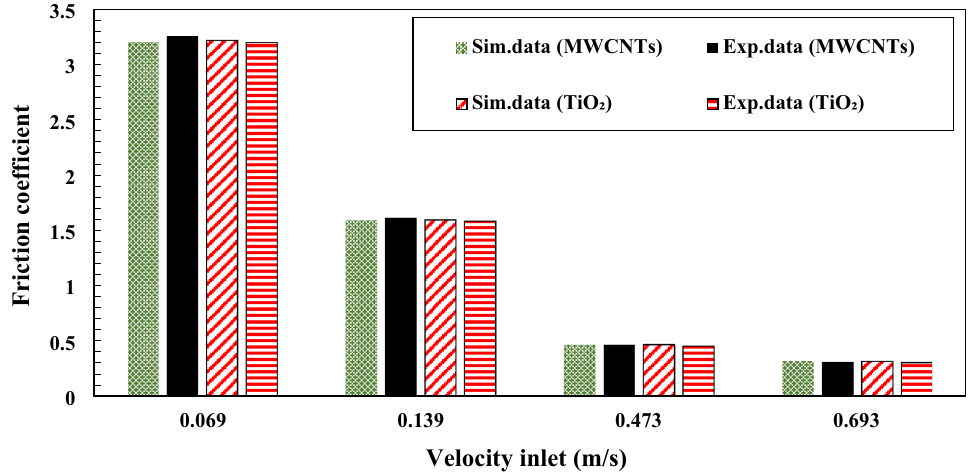
Figure 20. Comparison of experimental and simulation data of the average friction coefficient at the 0.05– 0.4 wt.% of TiO 2 and MWCNTs nano additives.